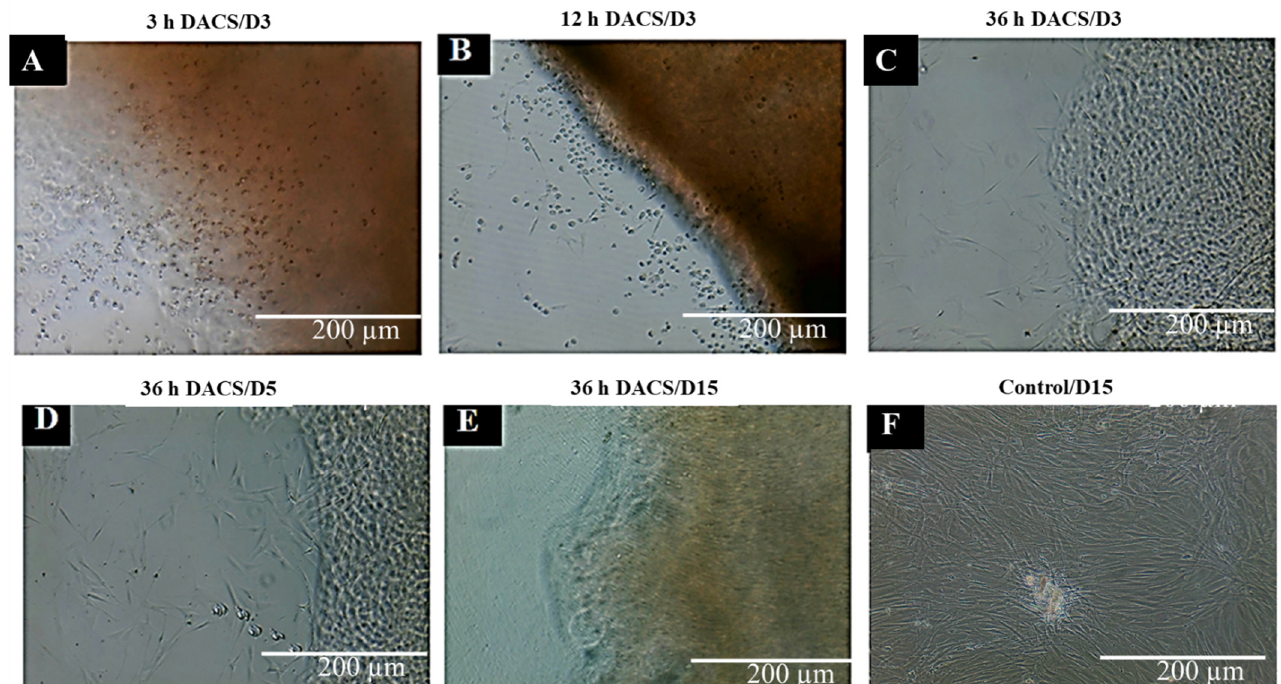
Figure 11. Microphotographs of the relative cytotoxicity of DACS scaffold on chondrocytes via phase-contrast microphotography. ( A ) 3-h decellularized DACS reseeded with Chondrocytes and cultured for 24 h. ( B ) 12-h decellularized DACS reseeded with Chondrocytes and cultured for 24 h. ( C ) 36-h decellularized DACS reseeded with Chondrocytes and cultured for 24 h. ( D ) 36-h decellularized DACS reseeded with Chondrocytes and cultured for 5 days. ( E ) 36-h decellularized DACS reseeded with Chondrocytes and cultured for 15 days. ( F ) Monolayer plate control chondrocytes after 15 days of culturing.